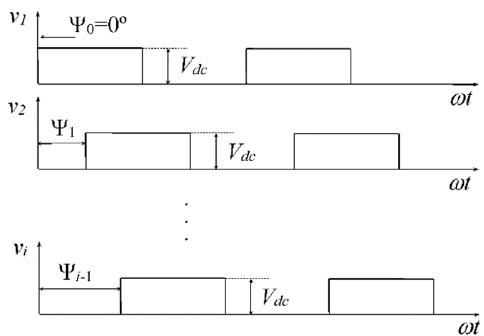
Figure 6. Output voltages of each inverter section obtained in the midpoint of the transistors leg. Using the fundamental approximation, the input voltages, v i , are represented with the